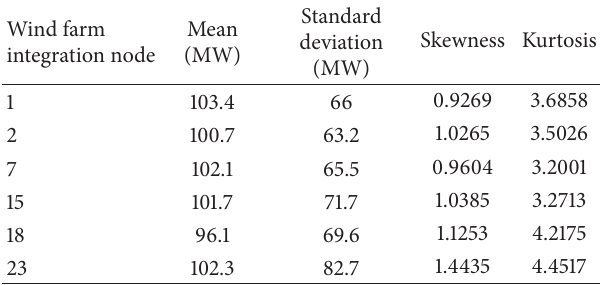
Table 1: Wind power input data of test